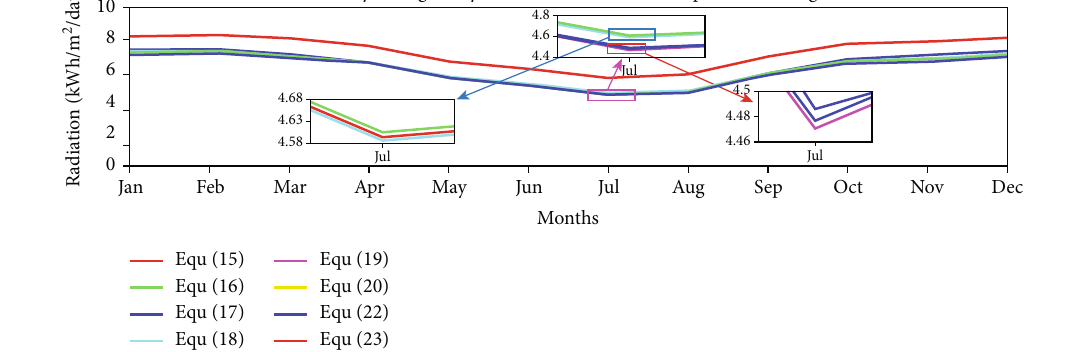
Figure 9: Monthly average daily solar radiation at monthly, seasonal, and yearly optimum tilt angle using the isotropic and anisotropic models, Bahir Dar city.